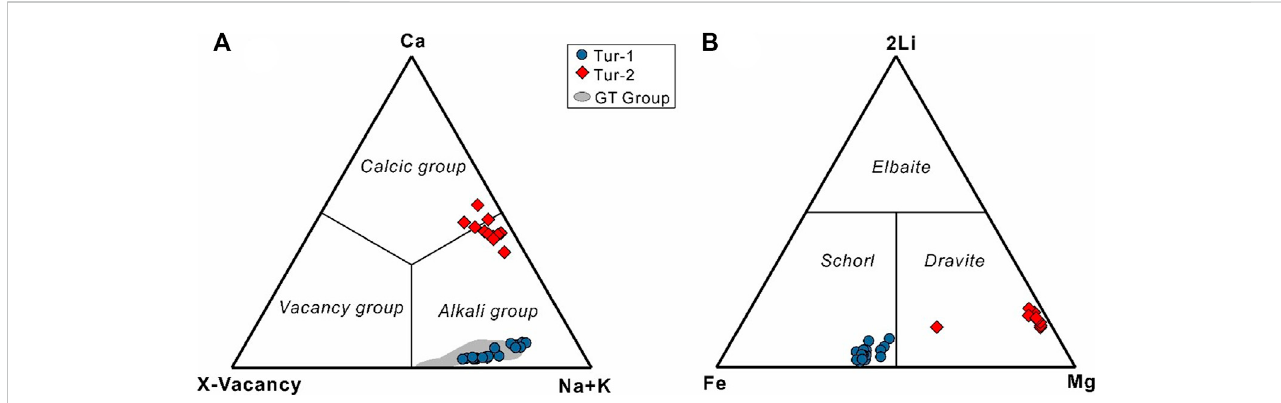
FIGURE 3 Classi fi cation of the principal groups of hydrothermal tourmaline Tur-1 and Tur-2 from the Cuonadong Sn – W – Be polymetallic deposit. The Ca-X- vacancy-Na+K (A) and 2 Li-Fe-Mg (B) ternary diagrams are obtained from Henry et al. (2011). The tourmaline data in the Cuonadong leucogranite from the Xinglin area (GT group, gray area) were obtained from Xie et al.